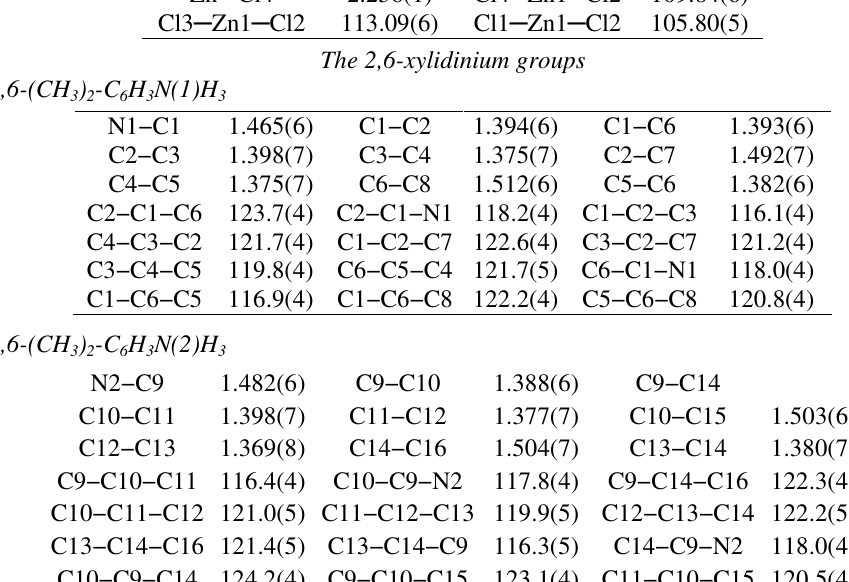
Table 3. Selected bond lengths (Å) and angles (°) in [2,6-(CH The ZnCl